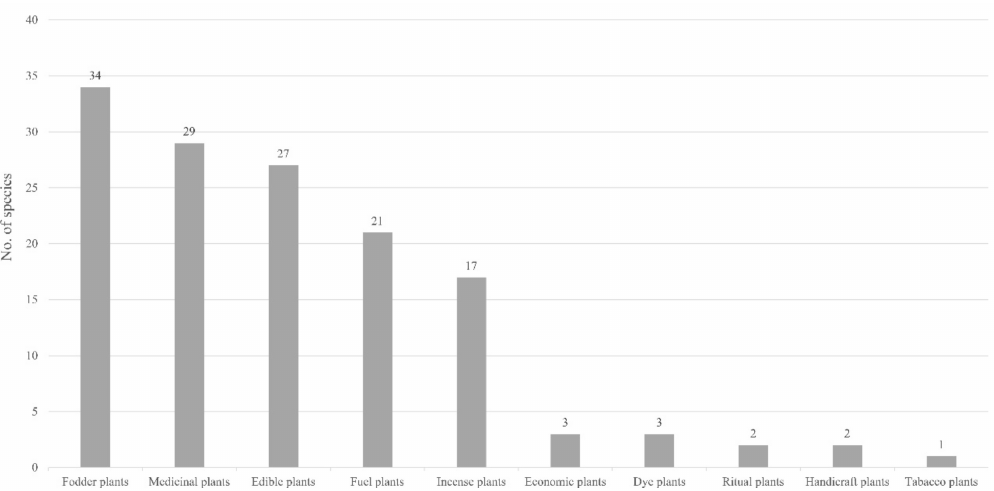
Figure 4. Plants used for different purposes in the study area. The abscissa indicates different pur‑ poses, and the ordinate indicates the number of plant species corresponding to different